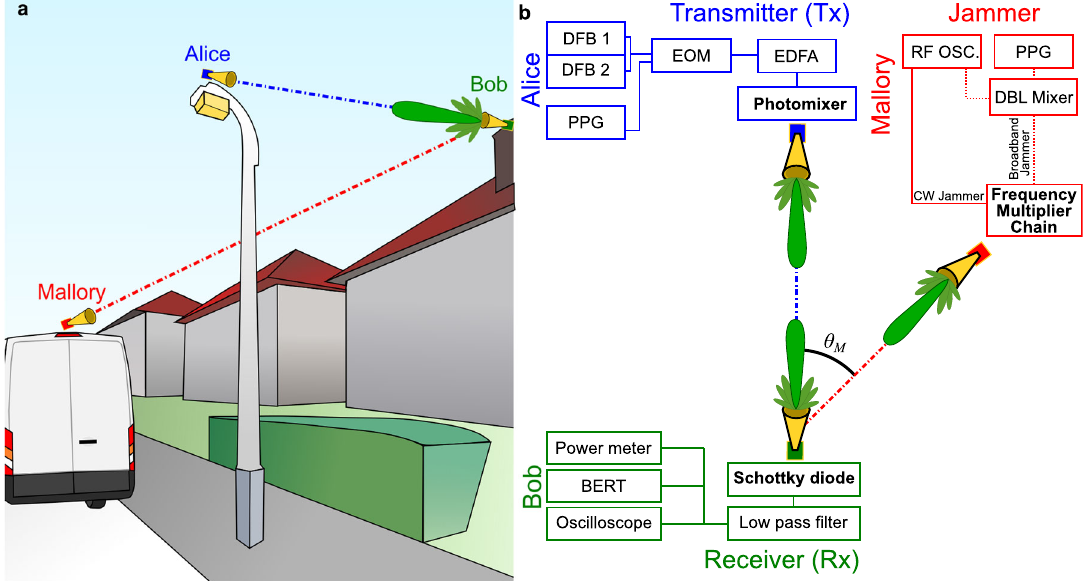
Fig. 1 Jamming attack. a Alice (blue) is transmitting to Bob (green) through a line-of-sight communication link, while Mallory (red) disrupts the data streaming by aiming at Bob ’ s receiver, targeting one of his side lobes. b Schematic of the experimental setup, see “ Methods ” for details. BERT bit-error rate tester. DBL Mixer double balanced mixer. DFB distributed feedback laser. EOM electro-optic modulator. EDFA erbium-doped fi ber ampli fi er. PPG pulse pattern generator. RF OSC RF Oscillator.